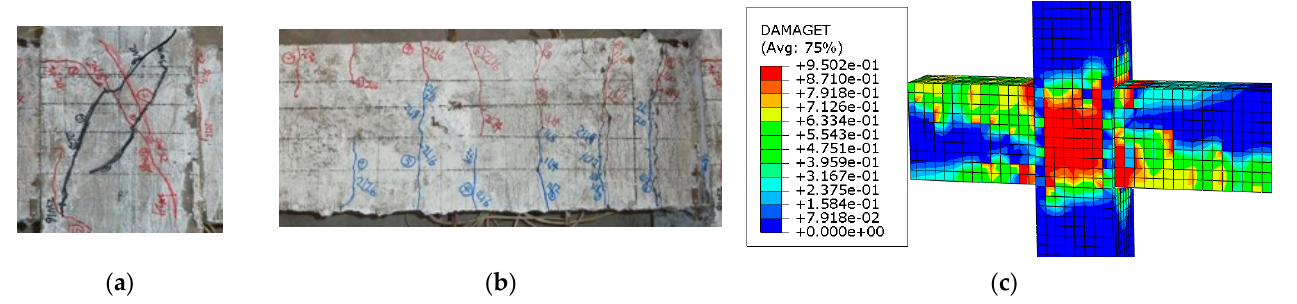
Figure 8. Failure model of BCJ5 specimen: ( a ) in the beam of test; ( b ) in the core joint of test; ( c ) in the FE analysis.